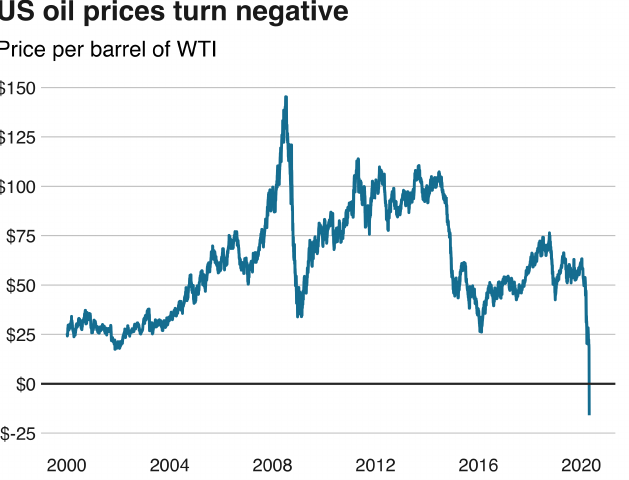
Figure 4. Energy price goes negative for zero demand of oil in 2020, during COVID-19 pandemic